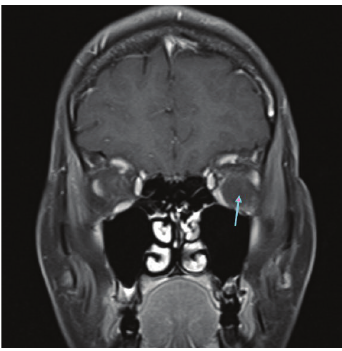
Figure 4: Coronal postcontrast T1 weighted MR image showing nonenhanced hypointense haematoma